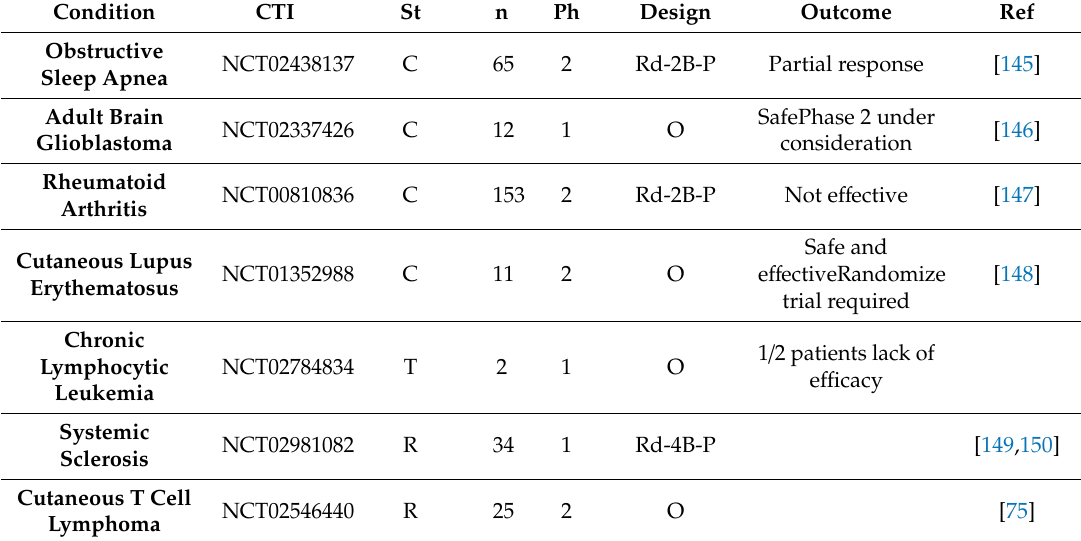
Table 1. Clinical trials with DMF for treatment of patients su ff ering from diseases other than psoriasis and